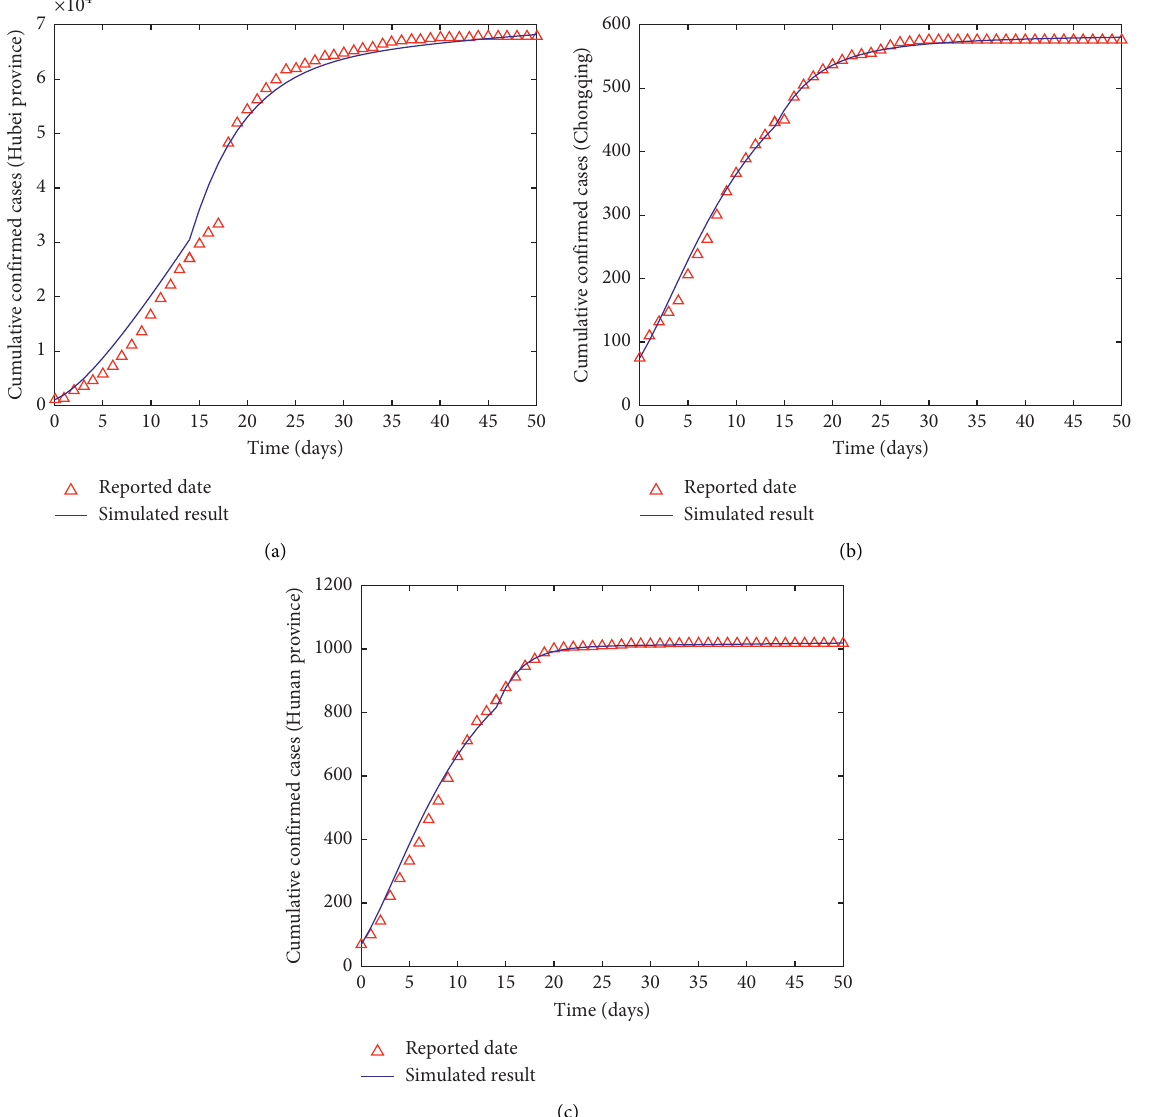
Figure 2: Fitting on the transmission of COVID-19 in (a) Hubei province; (b) Chongqing; (c) Hunan